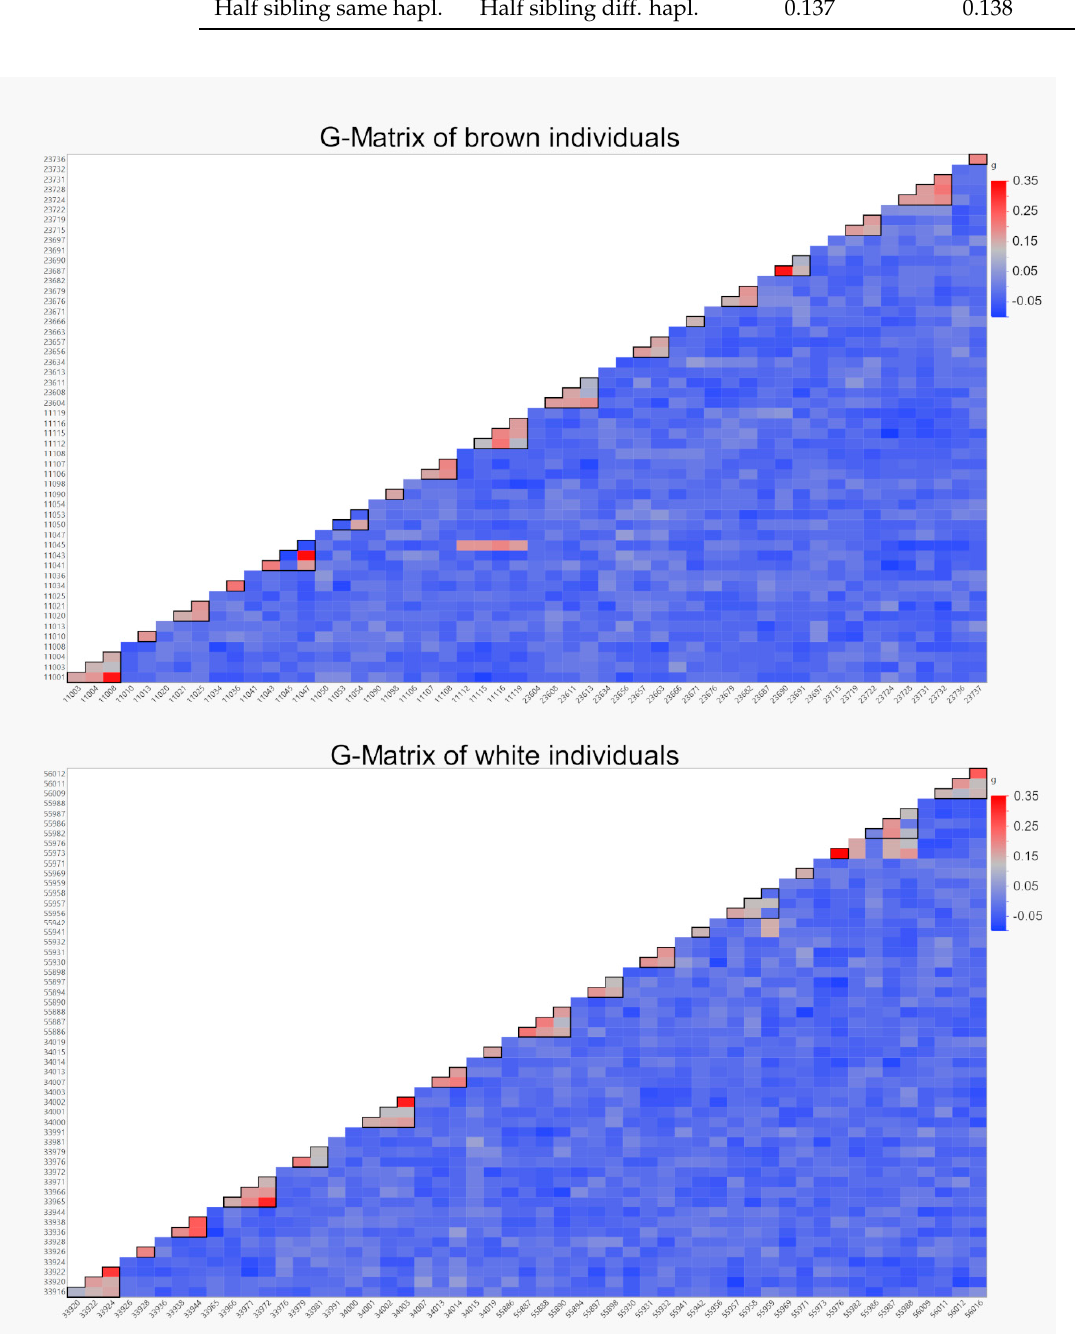
Figure 4. Heat maps of VanRaden G-Matrices for the brown and white individuals. Hens sharing the same father are marked (black lines), individuals are shown in the same order as in the ADMIXTURE plots. The elements of the diagonals are not shown.